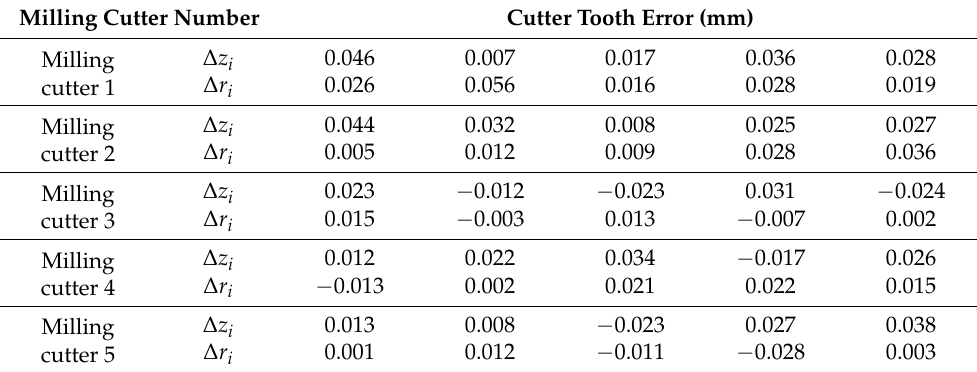
Table 3. Design variables for error distribution of milling cutter